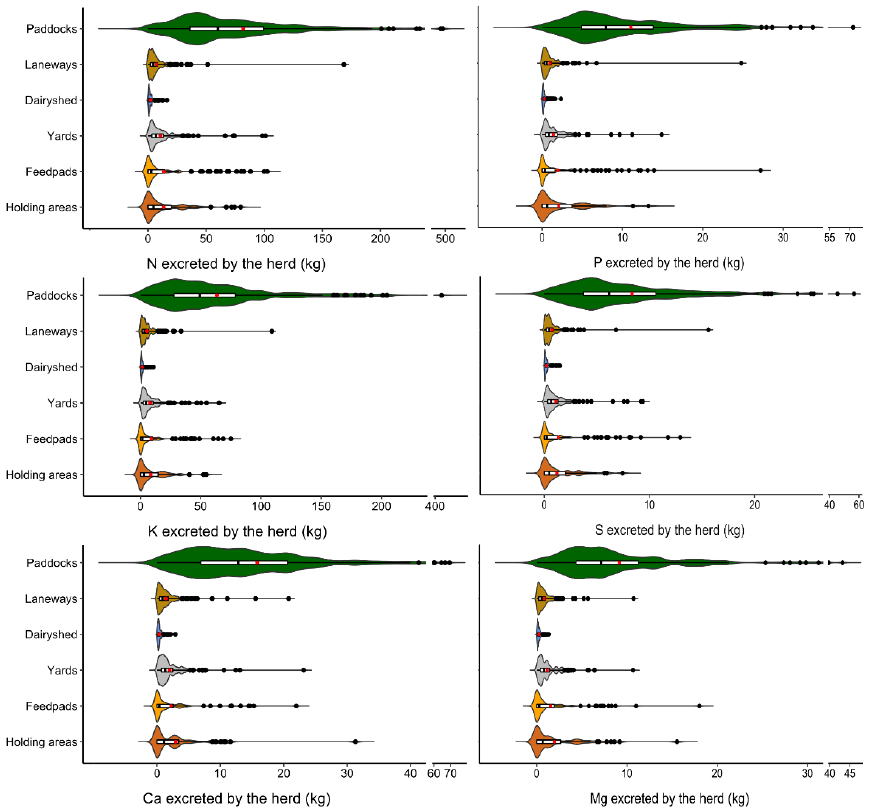
Figure 2. Violin (kernel density) plots of nutrients excreted by lactating herds in paddocks, laneways, dairy sheds, yards, feed pads and holding areas on commercial dairy farms, based on data collected at each of five visits over a year. Box and whisker plots are inside violin plots, with boxes representing the interquartile range (IQR; 25th to 75th percentile), the internal line the median, and the red point the average; the whiskers extend to 1.5 times the IQR.